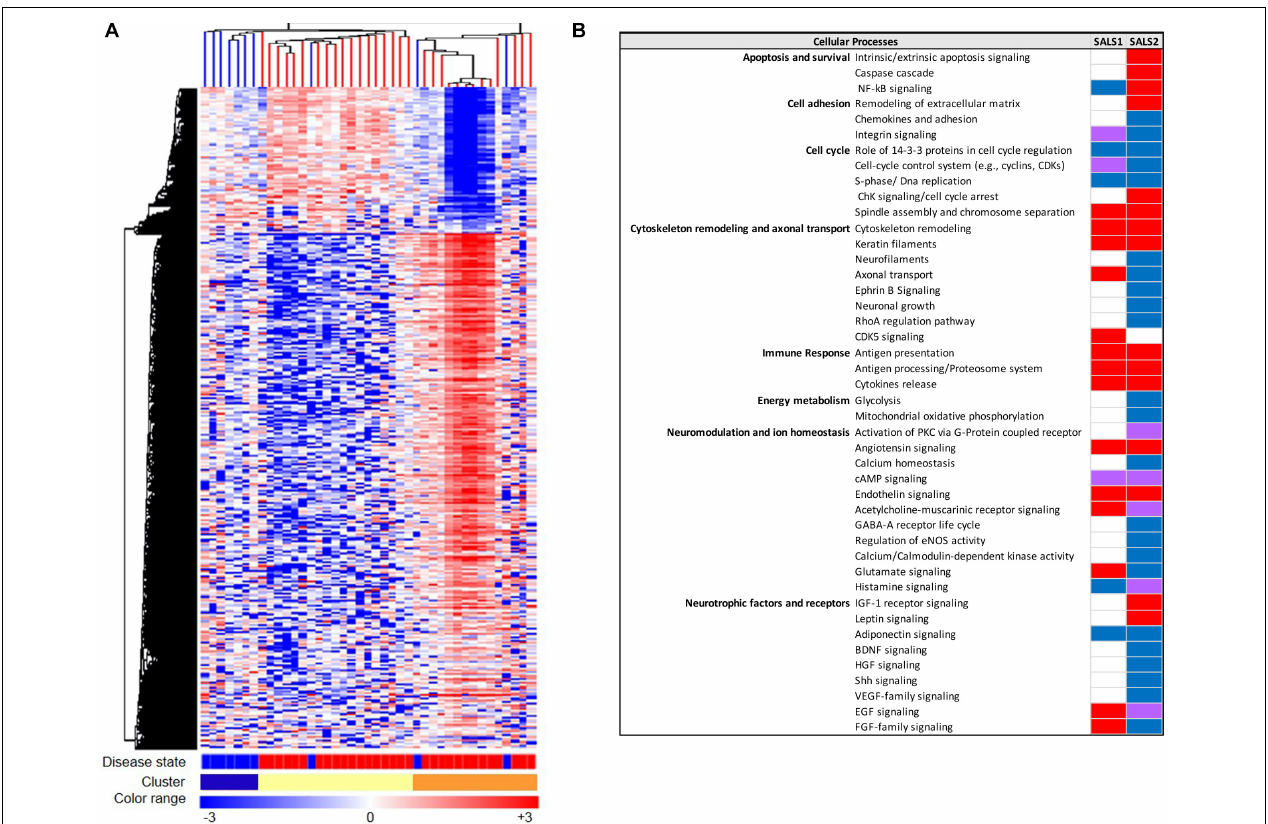
FIGURE 2 | Molecular-based classification of SALS. (A) Unsupervised hierarchical clustering (similarity measure: Pearson centered; linkage rule: average) was used to cluster control (10 fresh-frozen motor cortex samples from non-neurological patients) and SALS patients (31 fresh-frozen motor cortex samples) on the basis of the similarity in expression profiles of the most "hypervariable genes" (9.646 genes with a standard deviation > 1.5). The same clustering method clearly distinguished two SALS subgroups (SALS1 and SALS2), each associated to differentially expressed genes and pathways. In this two-dimensional presentation, each row represents a single gene and each column a motor cortex from control or SALS patients. As shown in the color bar, highly expressed genes are shown in orange, down-regulated genes in blue, no change in white. In the dendrograms shown (left and top), the length and the subdivision of the branches display the relatedness of the expression of the probes and the motor cortex (top). The disease state is marked as follows: controls patients are indicated by brown rectangles and SALS patients by red rectangles. In the cluster panel, red rectangle refers to control patients, brown to SALS1 and blue to SALS2 patients. For further details, the reader is referred to Aronica et al. (2015). (B) Functional pathways deregulated in clustered SALS patients. Orange boxes represent signaling pathways significantly up-regulated, blue bars down-regulated, green bars both up- and down-regulated, white bars indicate no significant change. Figure adapted from Morello and Cavallaro